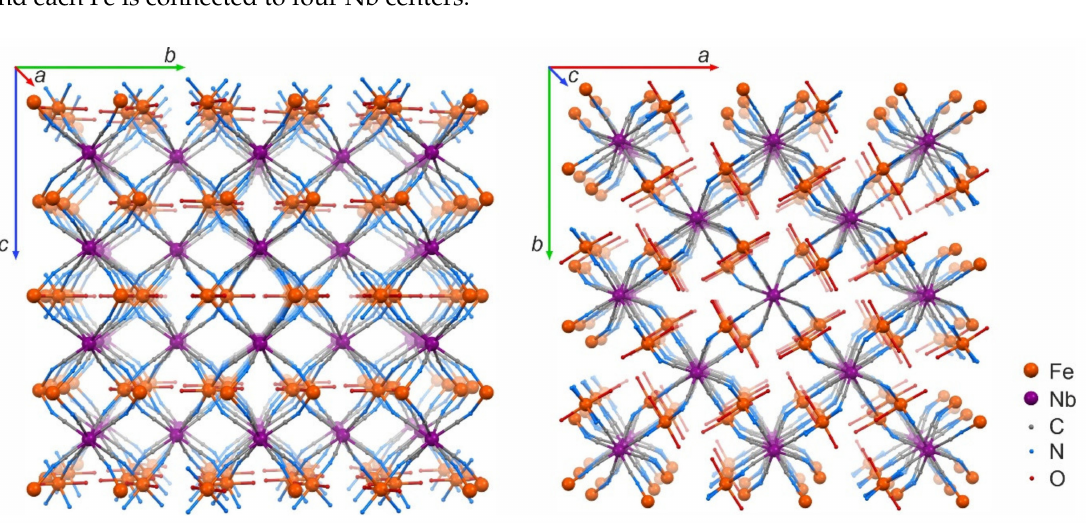
Figure 1. Packing diagrams presenting the crystal structure of {[Fe II (H 2 O) 2 ] 2 [Nb IV (CN) 8 ] · 4H 2 O} n as viewed along the a ( left ) and c ( right ) crystallographic direction (crystallization water molecules and hydrogen atoms omitted for the sake of